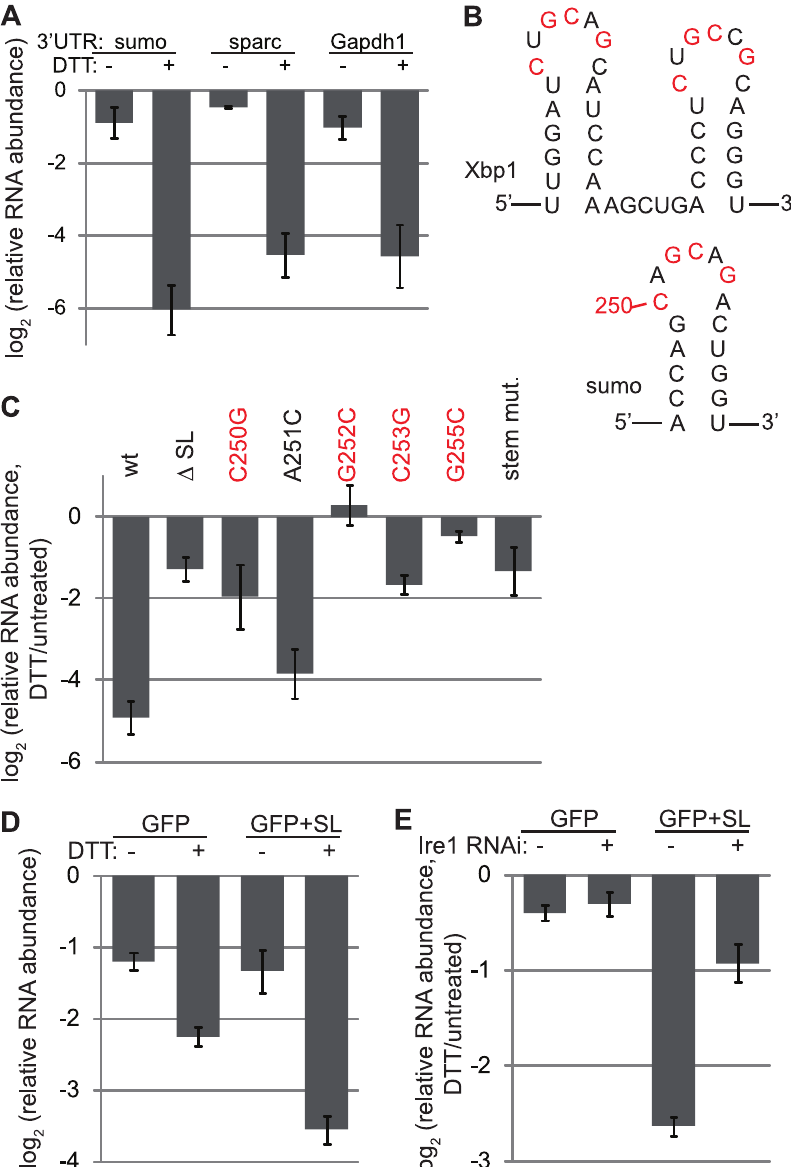
Figure 2. A stem loop sequence in the sumo mRNA is important for RIDD targeting. For panels A, C-E: plasmids expressing reporter mRNAs under the control of a copper-inducible promoter were stably transfected into S2 cells. After inducing expression, we removed the copper to stop transcription of reporter mRNAs, incubated cells in the presence and absence of ER stress (2 mM DTT, 5 hrs), and collected RNA samples. Relative RNA abundance was measured by qPCR and normalized to Rpl19. Shown are the averages and SDs of 3 (panels A, C) or 2 (panels D-E) independent experiments. A. Reporters expressing the coding sequence of sumo followed by various 3 9 UTRs. We normalized RNA levels to a control sample collected immediately before washing out the copper; thus RNA measurements reflect the amount of degradation after 5 hrs without copper. B. RNA sequences of sumo and Xbp1 from D. melanogaster, surrounding the stem loop structures discussed here. Highlighted in red are the loop nucleotides conserved in Xbp1 across species. Numbering in the sumo mRNA is relative to the translation start site. C. Reporters containing the sumo coding sequence and 3 9 UTR, with various mutations. D SL= deletion of nucleotides 244–270 in the coding sequence of sumo; stem mut.= C257G/G259C/ G260C. D. Reporters expressing GFP with the Gapdh1 3 9 UTR, with and without the stemloop sequence of sumo (nt 244–270). E. Degradation of reporters from D in untreated cells and those depleted of Ire1. doi:10.1371/journal.pone.0075723.g002 were reduced to 39% + / 2 7% compared to controls, as measured (Figure 4B) and degradation of RIDD targets CG3984, Hydr2, by qPCR. These data suggest that Ire1-dependent degradation of and sparc (Figure 4C) were largely unaffected, although degrada- sumo mRNA is particularly sensitive to Perk activity. tion of CG6650, another RIDD target, was partially inhibited. Western blot analysis of the phosphorylation of eIF2 a confirmed the efficient knockdown of Perk (Figure 4A), whose mRNA levels